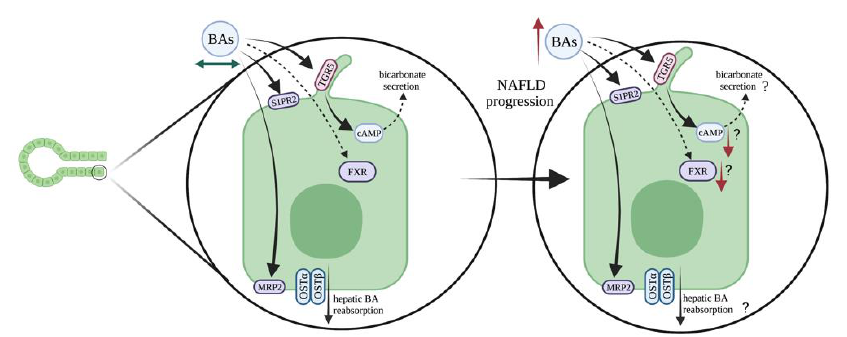
Figure 6. Potential roles of bile acid signaling in NAFLD progression. Under homeostatic conditions in the liver, TGR5 and S1PR2 are two of the apical membrane bile acid (BA) receptors present on cholangiocytes and are predominantly responsible for bile acid signaling across the biliary epithelium. An increase in total bile acids is a feature observed in NAFLD patients and in murine models. This can be primarily a result of reduced expression and localization of TGR5 or S1PR2 on the apical membrane and reduced FXR activation in cholangiocytes, which usually binds to bile acids and facilitates downstream pathways. This event might be considered as the initiation of a cascade of signaling events that ultimately leads to disruption of bile homeostasis across the biliary epithelium, thereby contributing to the NAFLD phenotype. Image made with BioRender (https://biorender.com/).